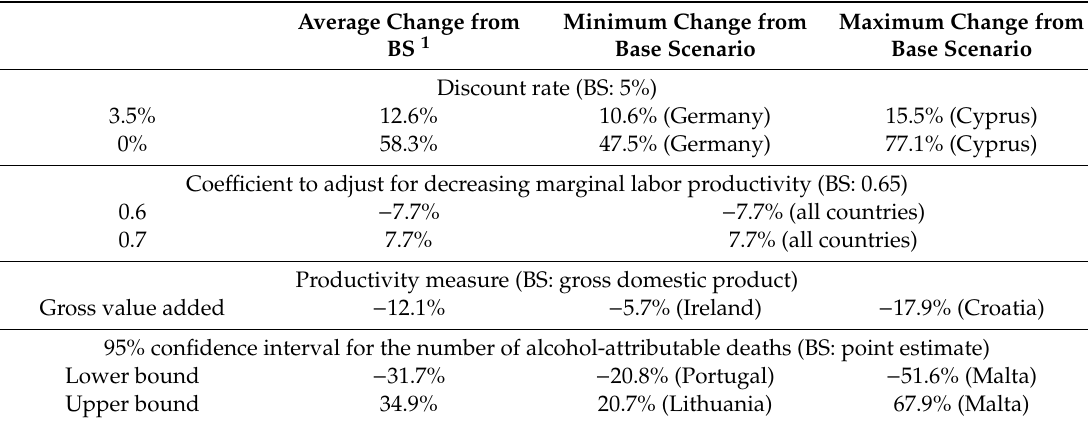
Table 3. Sensitivity analysis for estimates of production losses associated with alcohol-attributable mortality in 28 European Union countries,